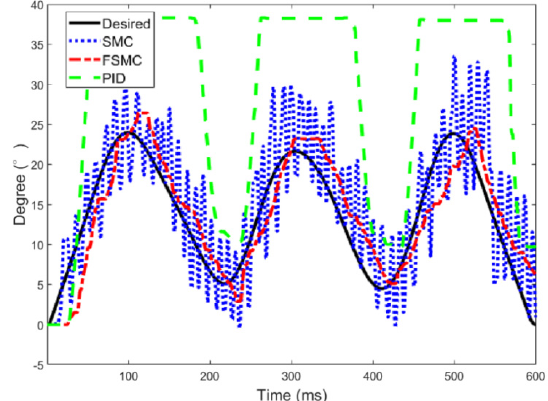
Figure 11. Trajectories of shoulder joint J 1 .